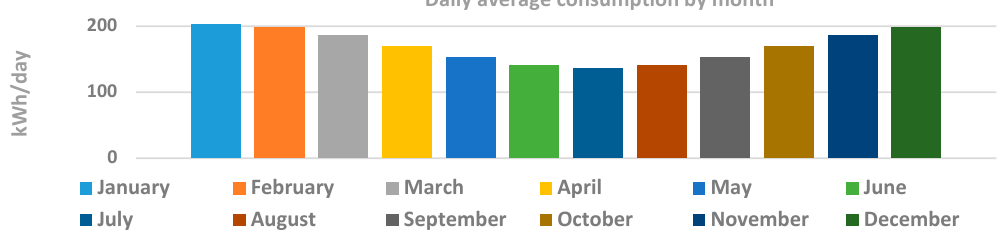
Figure 1. Daily average consumption by